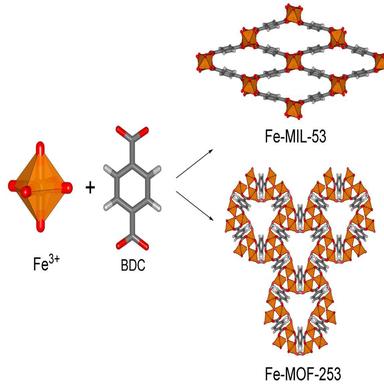
Scanning electron microscopy (SEM) of the Fe-BDC-DMF powder.